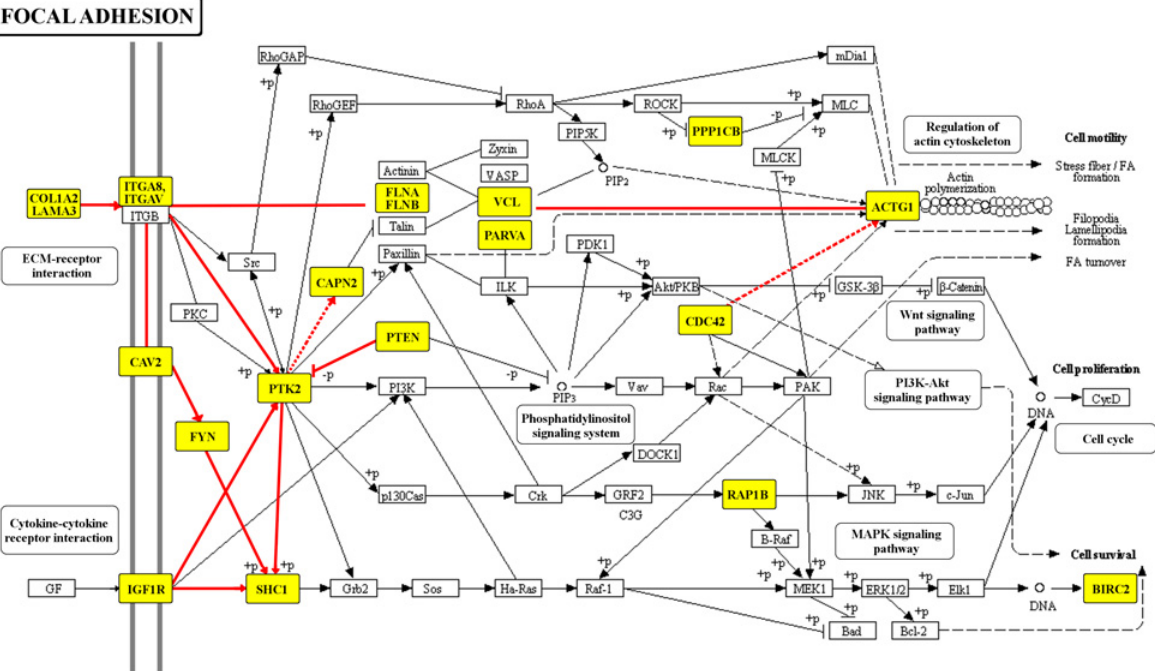
Fig 3. Focal adhesion pathway as a virulence factor target. We identified the Kyoto Encyclopedia of Genes and Genomes (KEGG) focal adhesion pathway as enriched with multiple virulence factor targets. The majority (17 of 20) of host proteins interacting with B. mallei virulence factors in this pathway belong to a connected sub-pathway of proteins (yellow boxes and red lines), mainly grouped at the beginning of the pathway. This observation implied that receptors and signaling molecules were likely B. mallei targets, corroborating previous observations that pathogens tend to interfere with host processes related to cell communication and actin cytoskeleton organization. The pathway diagram for the focal adhesion pathway was adapted from the KEGG pathway map [32] with permission from the KEGG database administrators.